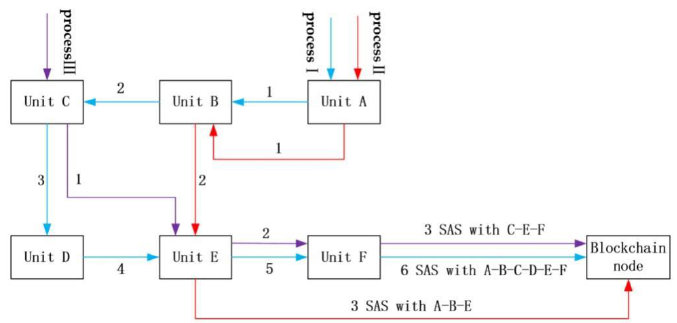
Figure 5. Sequential aggregate signatures in execution of production routing.